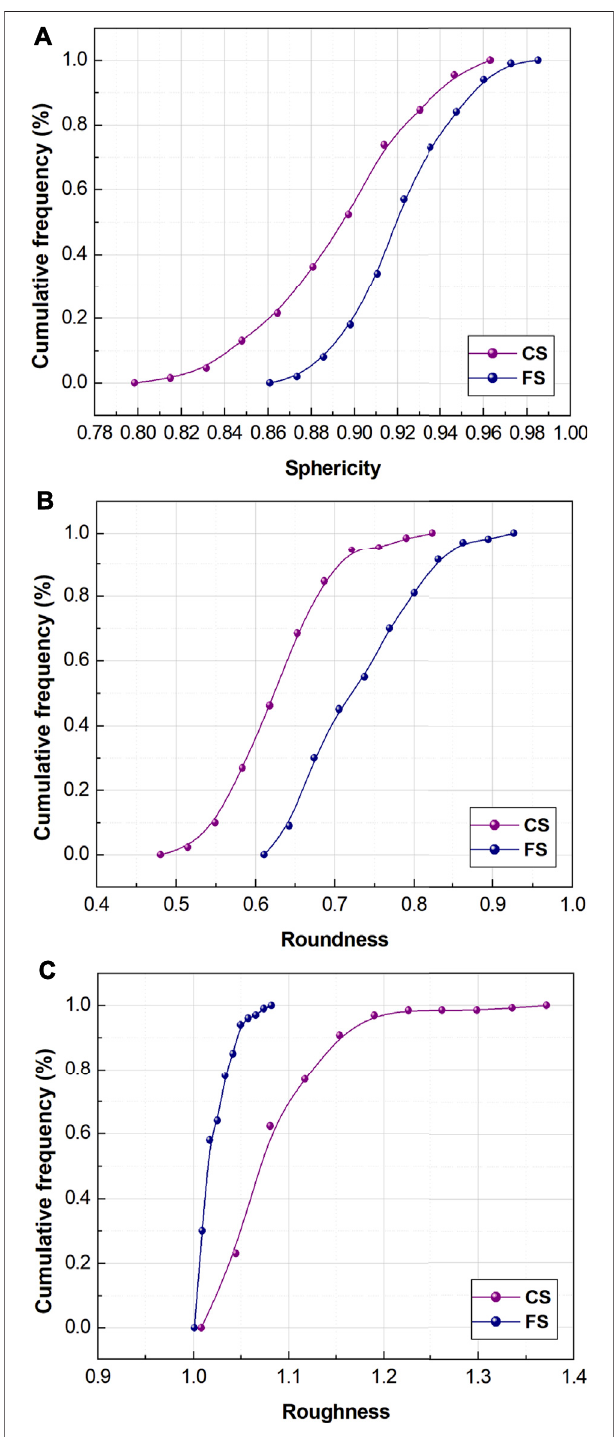
FIGURE 3 | Cumulative distribution functions of sphericity, roundness and roughness of the CS particles and FS particles (A) sphericity under f 2 - f 4 ; (B) roundness under f 5 - f 8 ; (C) roughness under f 9 - f 15 .